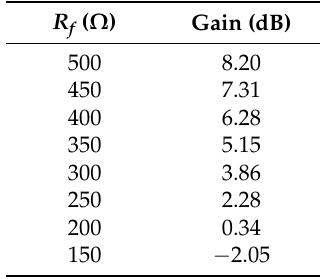
Table 11. The gain of the second stage of the proposed circuit at different R f values. R f ( Ω